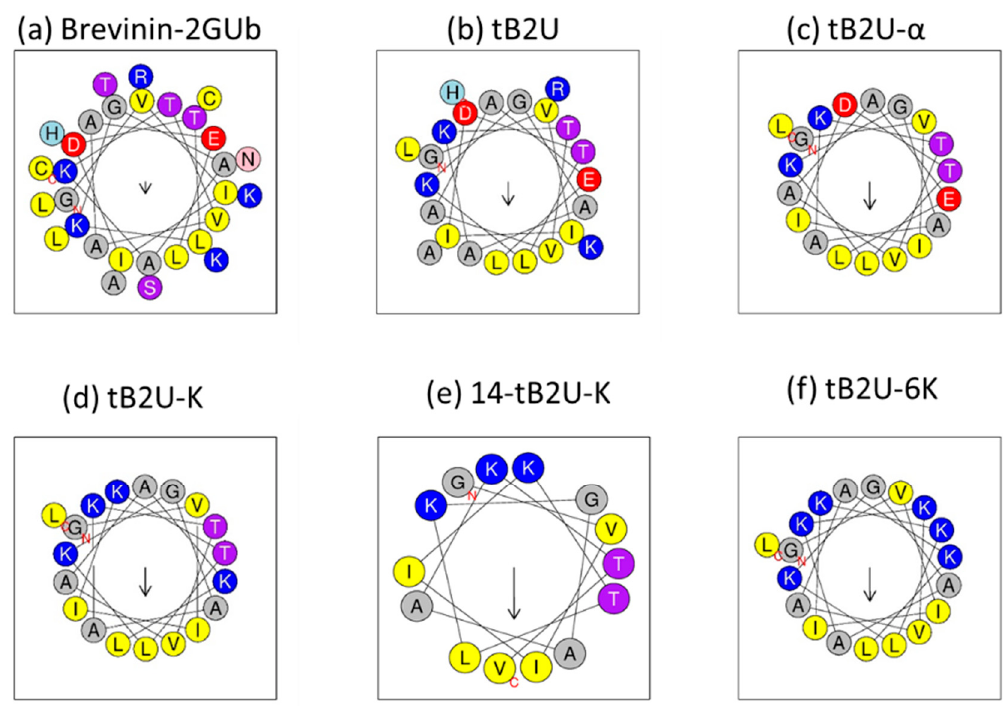
Figure 3. The helical wheel representations of ( a ) Brevinin-2GUb, ( b ) tB2U, ( c ) tB2U- α , ( d ) tB2U-K, ( e ) 14-tB2U-K, and ( f ) tB2U-6K predicted by Heliquest. The hydrophobic, hydrophilic, positively-charged, and negatively-charged amino acids are coloured by yellow, purple, blue, and red, respectively. Table 2. Secondary structure analysis of Brevinin-2GUb and its analogues.